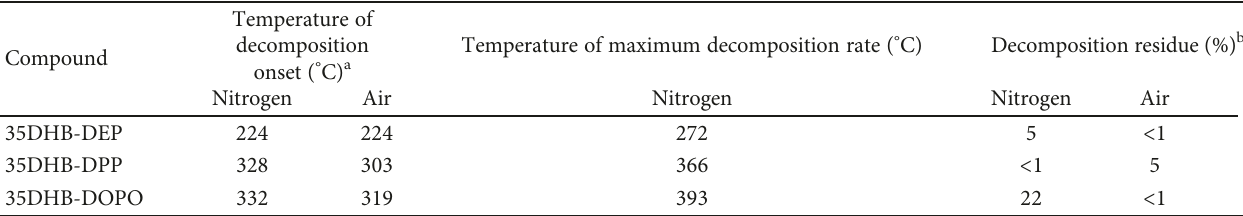
Table 5: Thermal decomposition of phosphorus esters of methyl 3,5-dihydroxybenzoate.